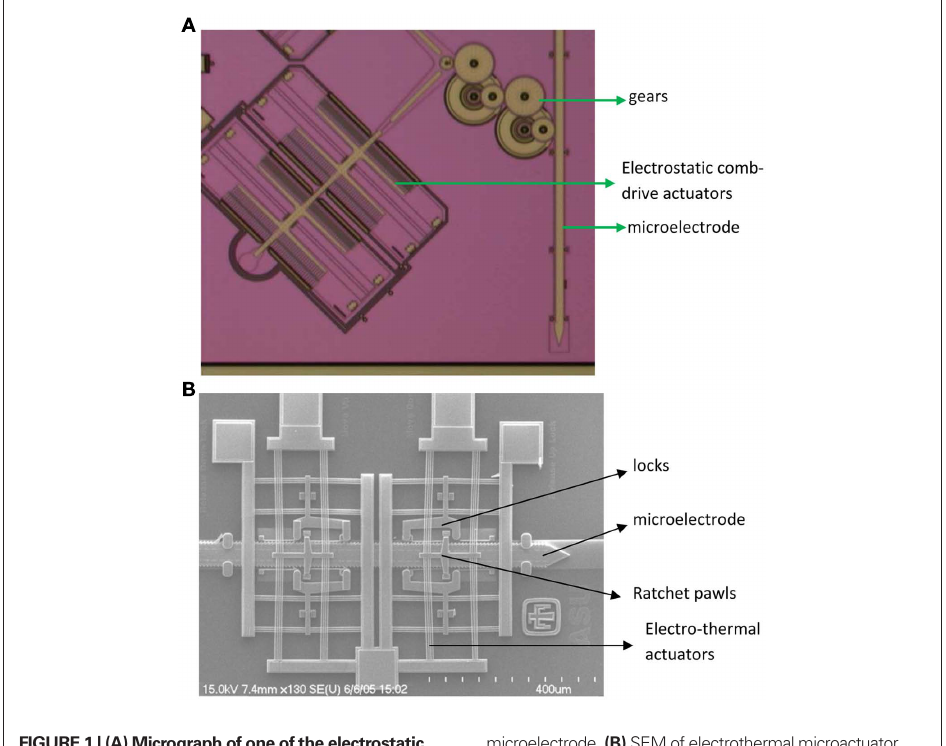
microelectrode. (B) SEM of electrothermal microactuator, microelectrode and associated ratchet pawls and locks. The microelectrodes in both cases are 50 μm